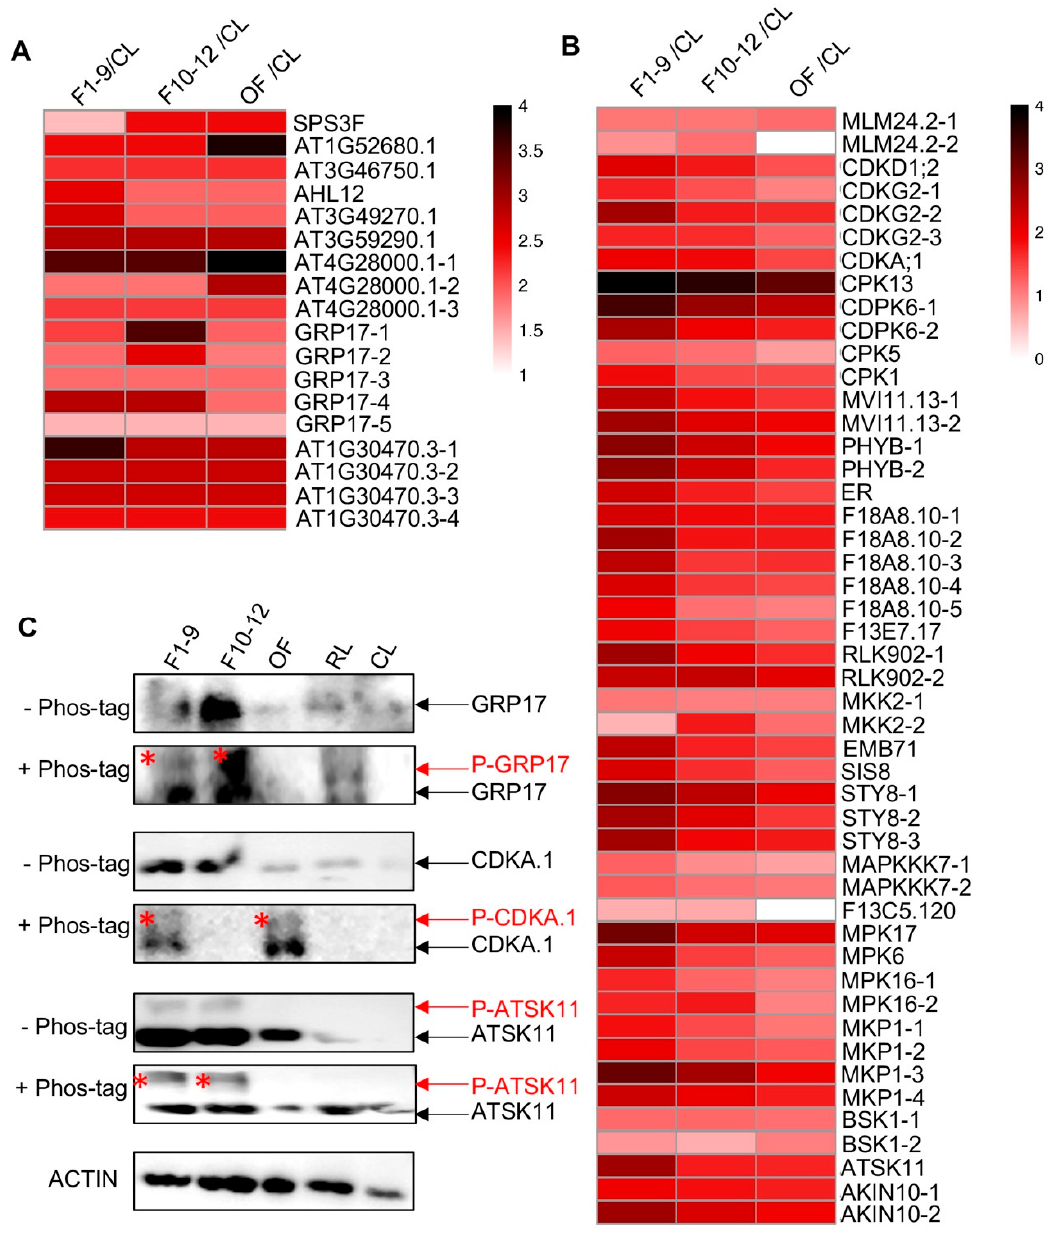
Figure 8. Reproductive organ-preferential phosphorylation of pollen proteins, phosphatases, and kinases. ( A ) Heat map showing the reproductive-organs-preferential-phosphorylation of pollen proteins. ( B ) Heat map showing the reproductive-organs-preferential-phosphorylation of phosphatases and kinases in reproductive organs. ( C ) Phos-tag SDS-PAGE showing the floral-organ-preferential phosphorylation of GRP17, CDC2 / CDKA.1, and ATSK11 proteins in reproductive organs. The asterisk represents the phosphorylated protein .